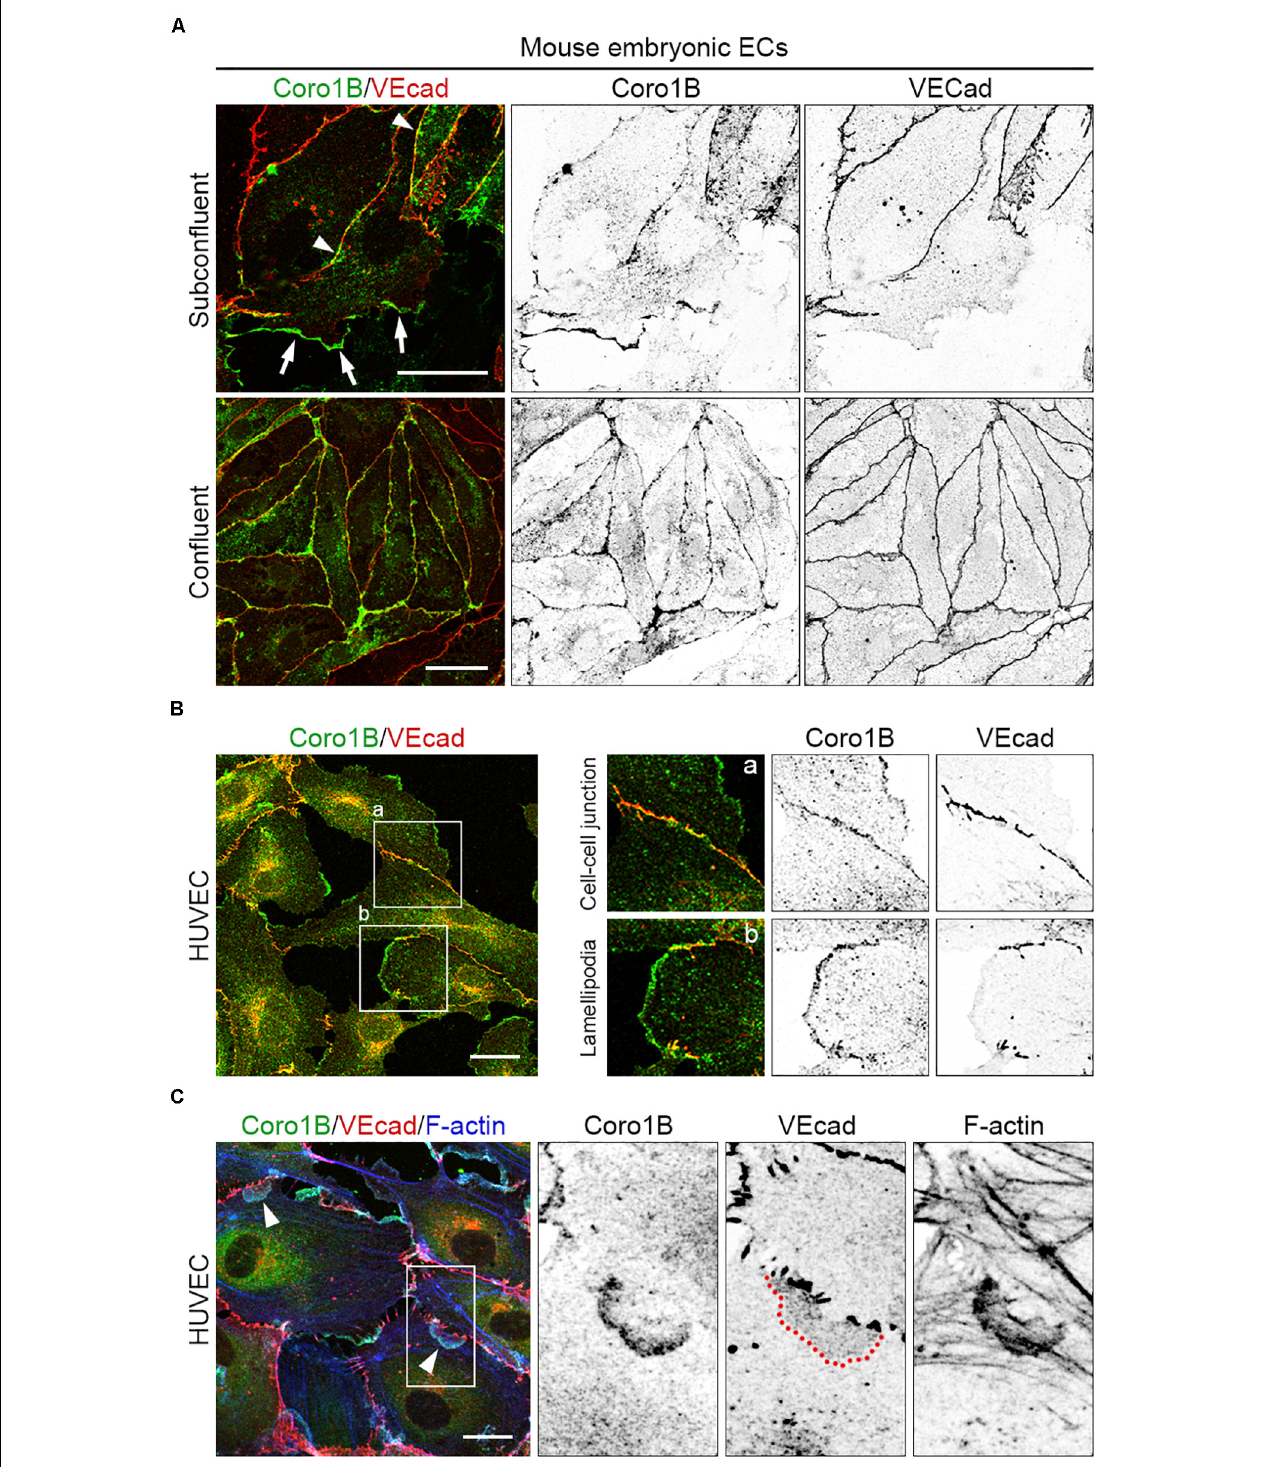
FIGURE 1 | Coro1B localizes to endothelial cell–cell junctions. (A) Mouse embryonic ECs immunostained for Coro1B (green) and VEcad (red) under subconfluent and confluent conditions. Arrows point to localization of Coro1B at classical lamellipodia, arrowheads indicate Coro1B at cell–cell junctions. (B) HUVECs labeled with Coro1B (green) and VEcad (red). Localization of Coro1B at cell–cell junctions (a, zoom-in right, upper panel) and at classical lamellipodia (b, zoom-in right, lower panel). (C) Localization of Coro1B (green), VEcad (red) and F-actin (blue) in subconfluent HUVEC monolayers. Arrowheads point to localization of Coro1B and F-actin at the leading edge of JAIL. Red line indicates VEcad plaque appearance. Scale bars = 25 µ m.